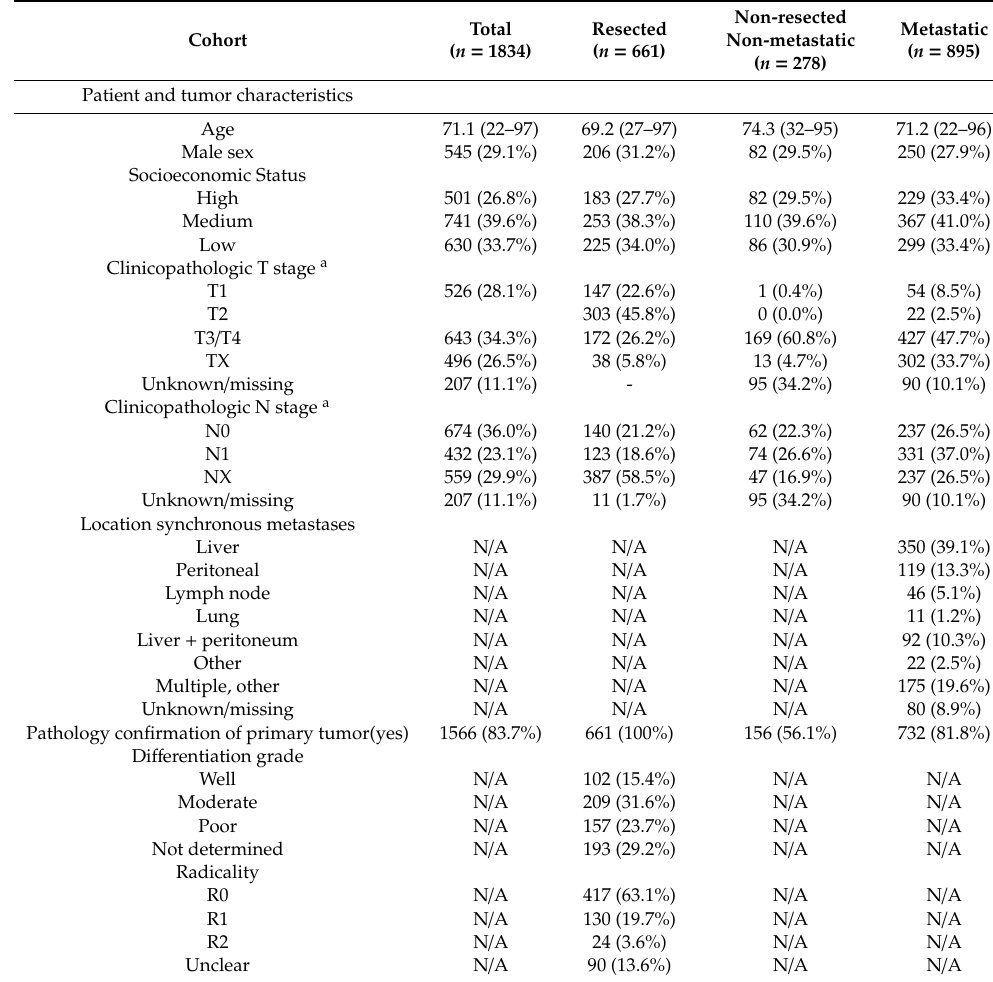
Table 1. Characteristics of patients with gallbladder cancer in the Netherlands